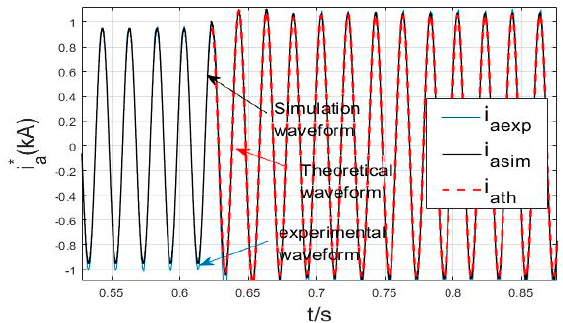
Figure 18. ( a ) Waveforms of d -axis output current. ( b ) Waveforms of q -axis output current.